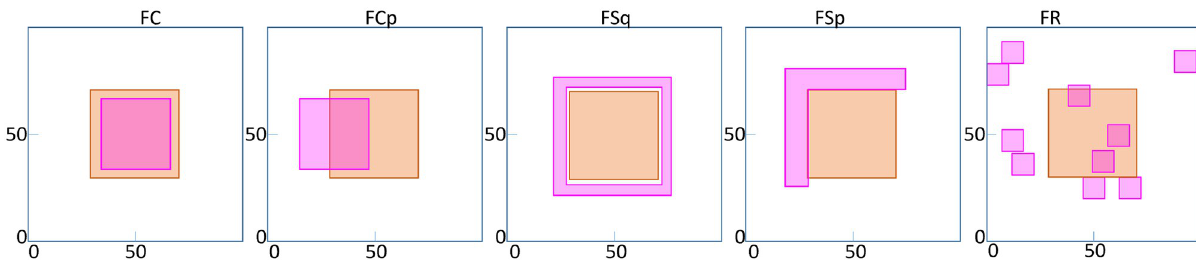
Fig 2. Fibroblast distribution. The pink shaded regions show the five types of representative CAF distribution (FC, FCp, FSq, FSp and FR). The orange square at the centre is the clump of R-cells. The dimensions have been provided in the text.